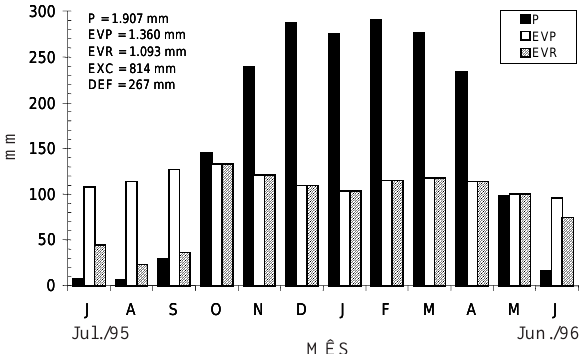
Figura 1. Balanço hídrico da região estudada (P: precipitação, EVP: evapotranspiração potencial, EVR: evapotranspiração real, EXC: excedente hídrico, DEF: déficit hídrico), no período de julho de 1995 a junho de